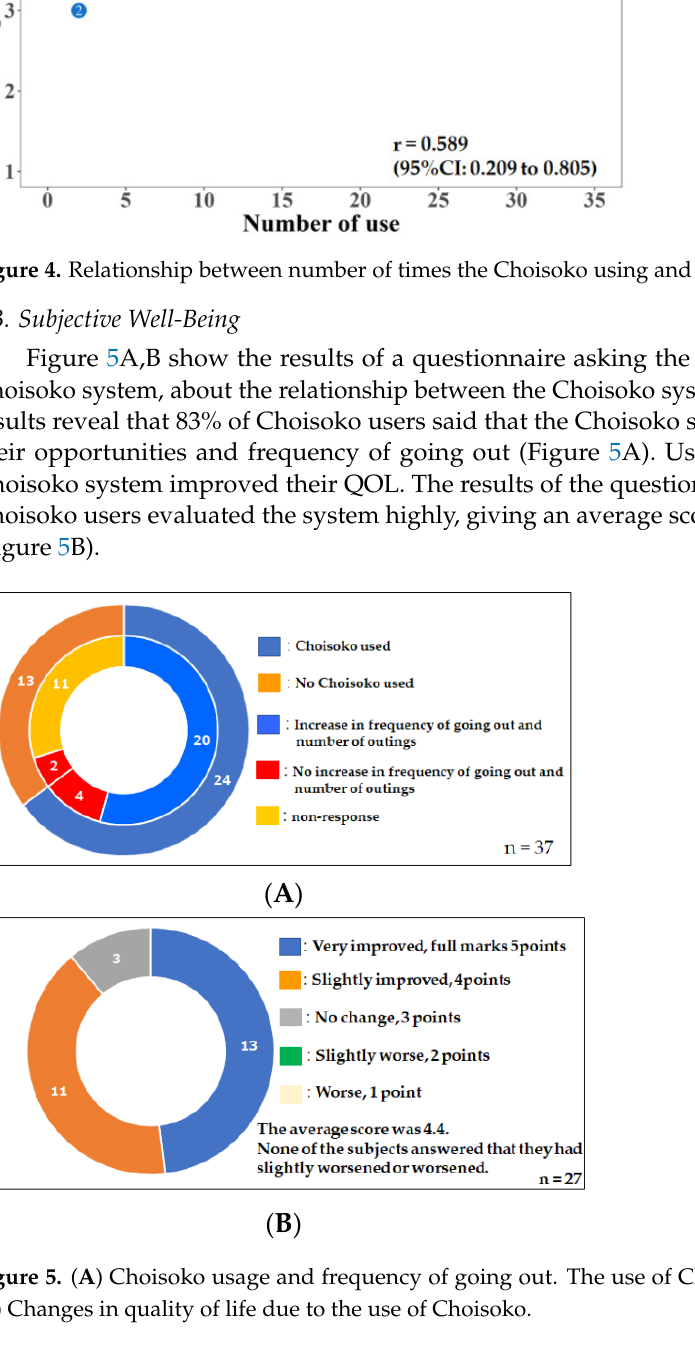
Figure 3. ( A ): relationship between the amount of change in the total FIM score and the number of times the choisoko is used. ( B ): the relationship between the amount of change in the FIM exercise score and the number of times the choisoko is used. ( C ): the relationship between the amount of change in the FIM cognitive score and the number of times the choisoko is used.